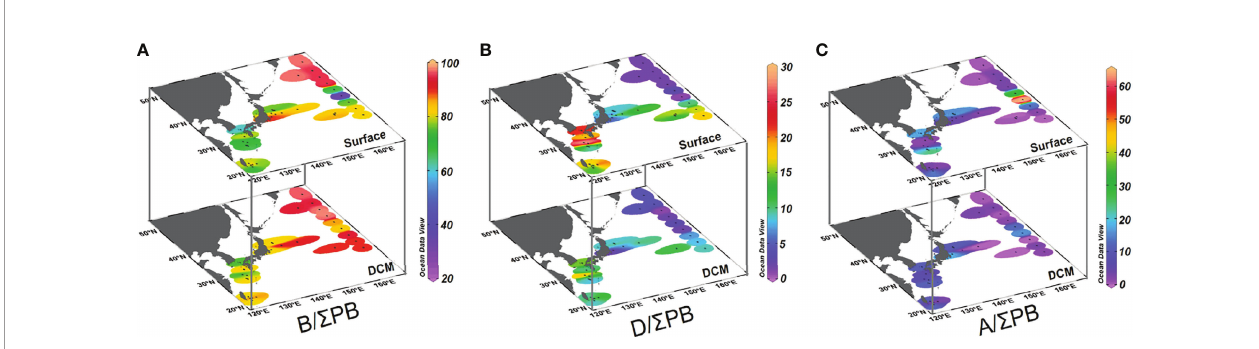
FIGURE 4 | Distributions of individual lipid biomarker proportions (% of the sum of the three lipid biomarkers [ S PB]) in surface and DCM waters of the Northwest Paci fi c Ocean in summer: (A) (brassicasterol/epi-brassicasterol)/ S PB, (B) dinosterol/ S PB, and (C) C37 alkenones/ S PB. Note the difference in color